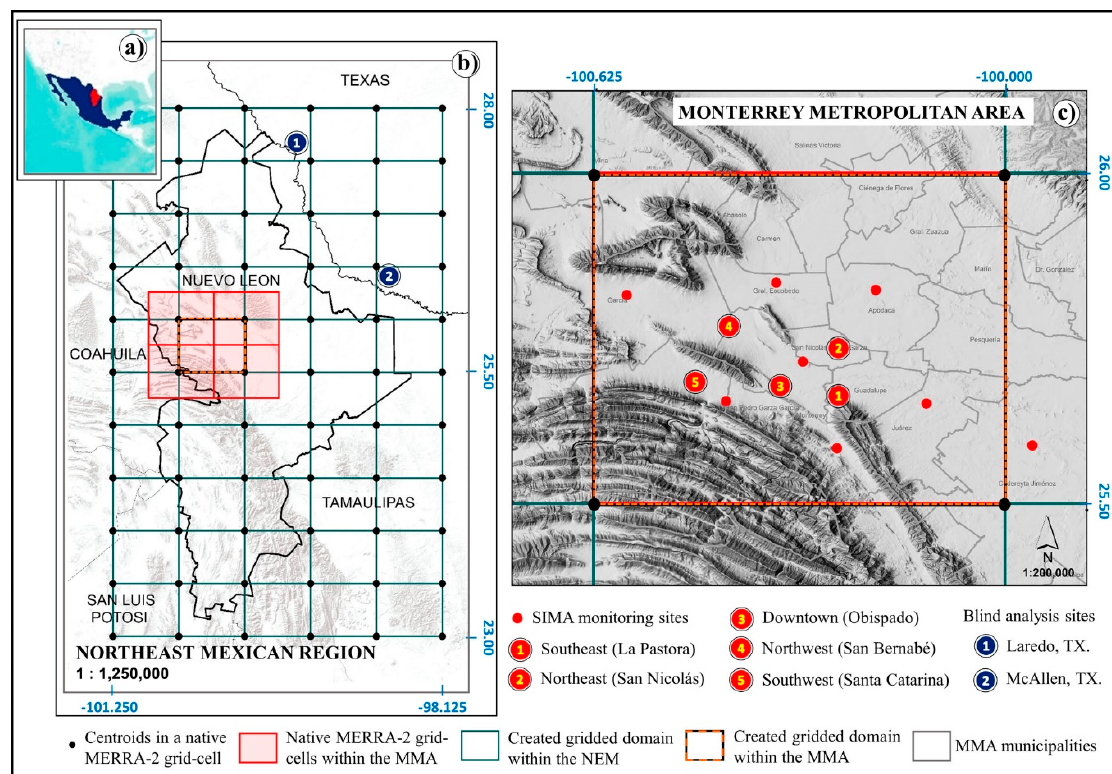
Figure 2. Study area location. ( a ) The MMA is located in the northeastern Mexican state of Nuevo Leon (shown in red). ( b ) Regional grid: vertexes correspond to the centroids of the native MERRA-2 grid. ( c ) Location of SIMA monitoring sites within the MMA.